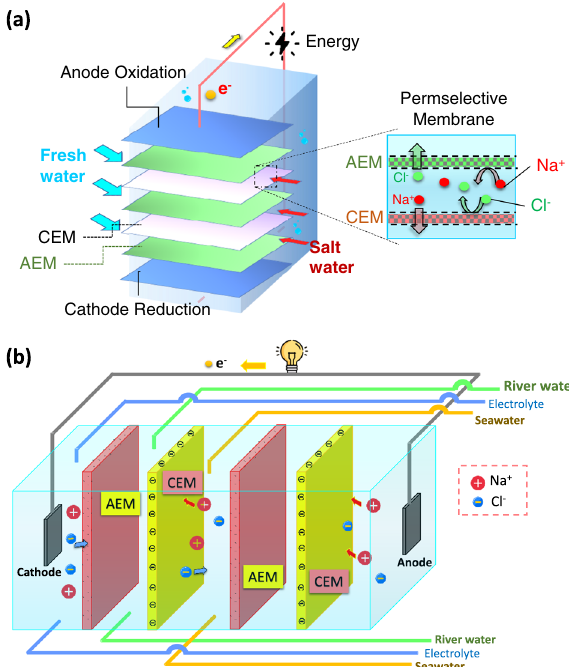
Fig. 3 Reverse electrodialysis (RED) for salinity gradient energy recovery. a Vertical representation of a reverse electrodialysis mechanism [adapted from ref. 28 ] and b Horizontal representation of a reverse electrodialysis